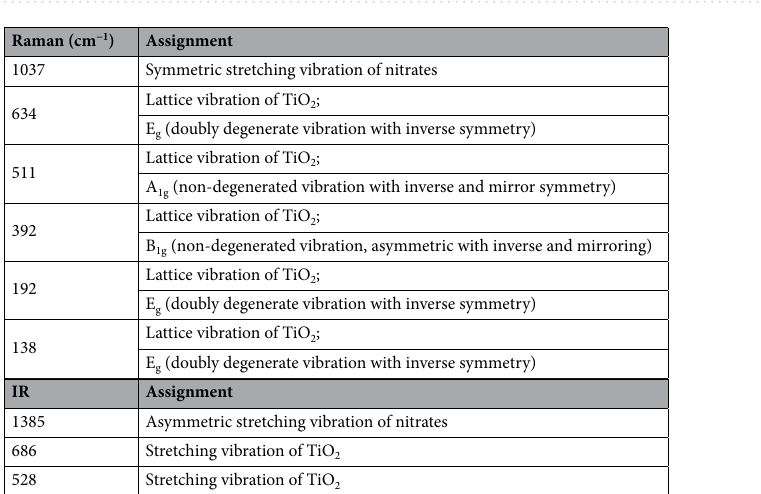
Figure 3. Raman ( A ) and IR ( B ) spectra of pure TiO 2 -A and TiO 2 -A-0.5% Ag and TiO 2 - A-2.5% Ag powders, where most intensive bands are noted.